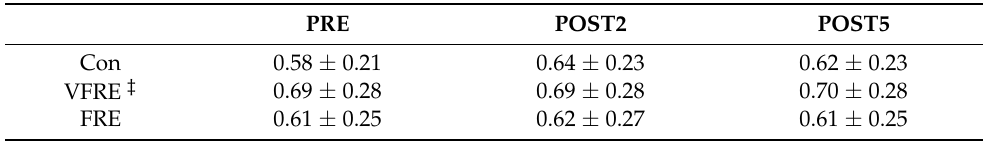
Table 6. The ankle power of DJ (W/BW); mean ± SD + . PRE